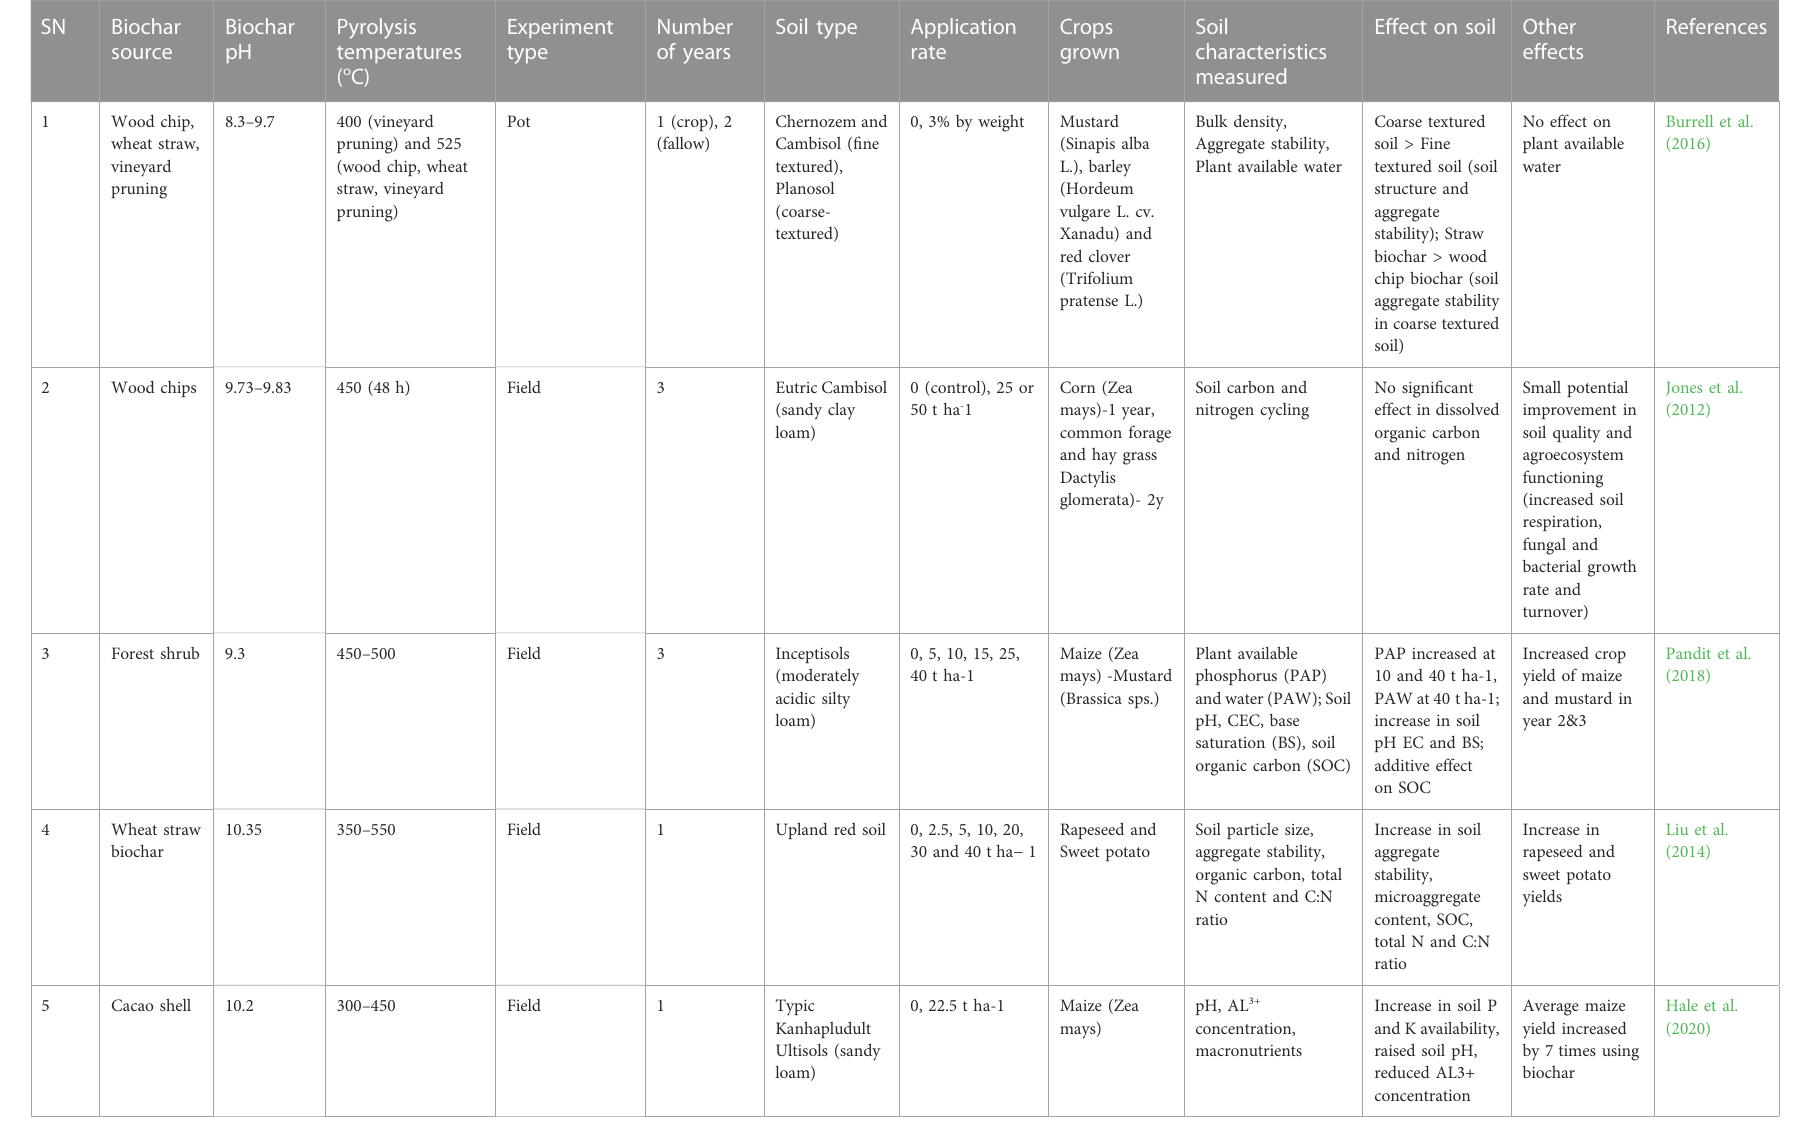
TABLE 1 Biochar effect on soil physical and chemical properties across different